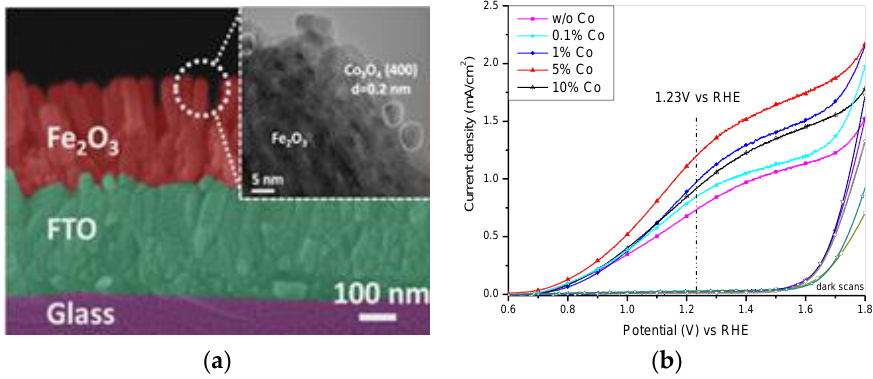
Figure 3. ( a ) Cross-section SEM image of hematite after annealing at 550 °C for 2 h and ( b ) I-V curves of hematite photoanodes with different amounts of Co 2+ added to the precursor solution. Reprinted with permission from Reference [32], copyright (2012) American Chemical Society.